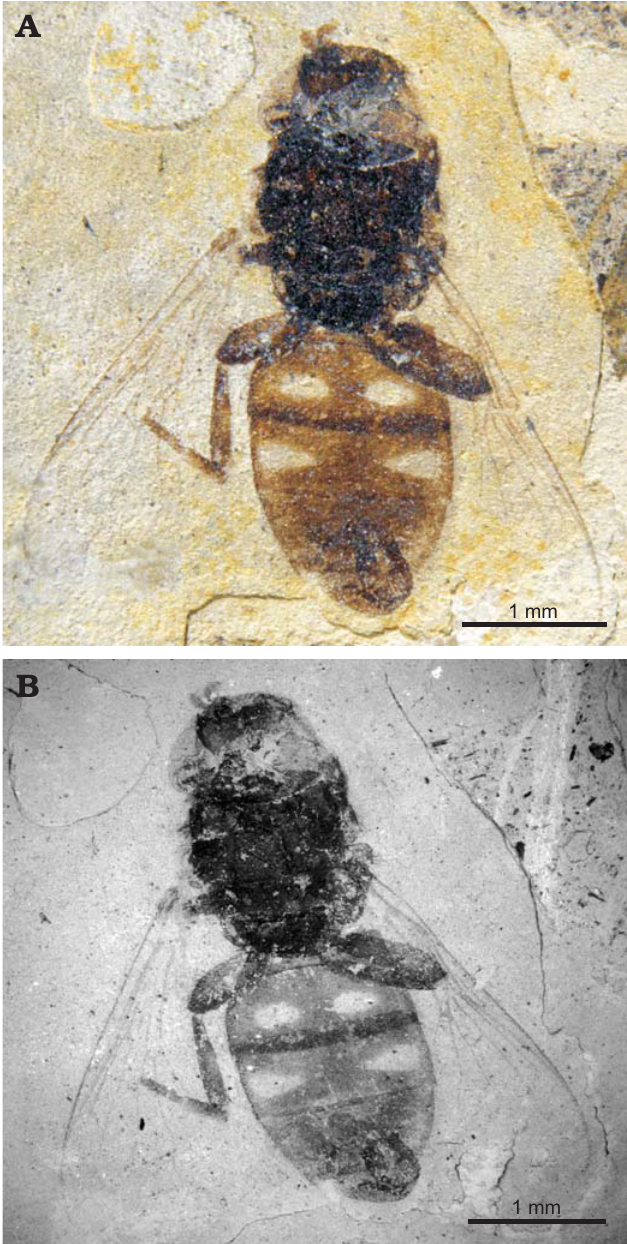
Fig. 1. Pipizine hoverfly Oligopipiza quadriguttata Nidergras, Hadrava, and Nel gen. et sp. nov., holotype RNGL-S01; Rupelian, Céreste, France. Imprint of male habitus. Normal light photograph ( A ), ESEM photograph ( B